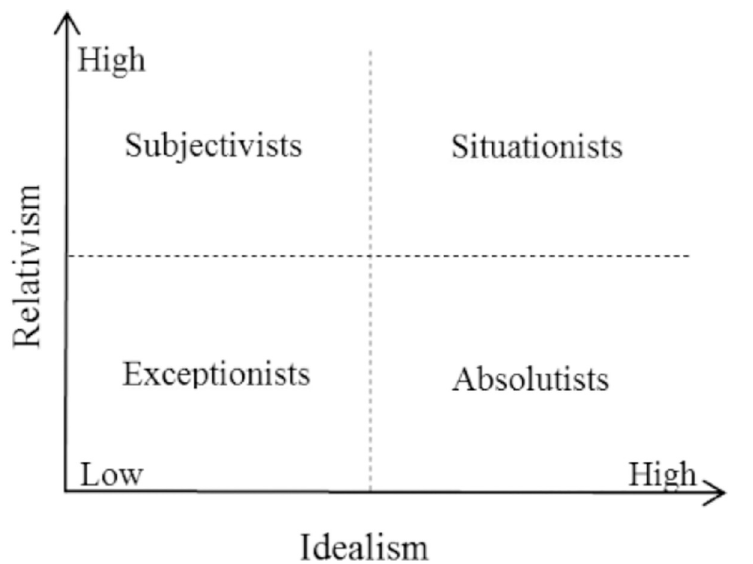
Fig 1. Ethical positions according idealism and